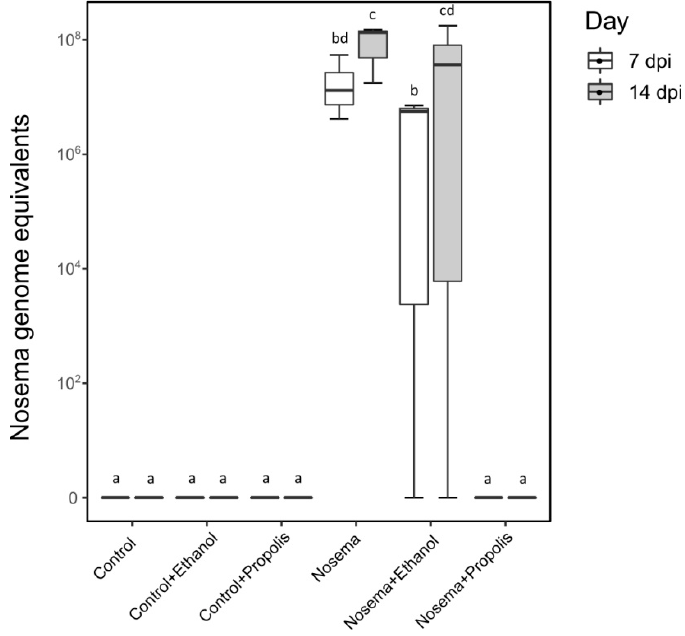
Figure 3. Nosema ceranae genome equivalents per honey bee ( Apis mellifera ) in treatments: Control, Control + Ethanol, Control + Propolis, Nosema, Nosema + Ethanol, and Nosema + Propolis at 7 and 14 days post experimental infection (dpi). Different letters correspond to significant differences between treatments at p < 0.05 (LMM and post-hoc pairwise contrasts adjusted for multiple comparisons with the Benjamini-Hochberg method to control the false discovery rate).